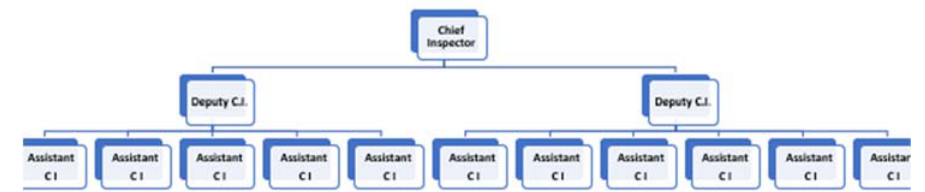
Figure 2. Structure of State inspection (October 2021). Figure 3. Structure of State inspection (October